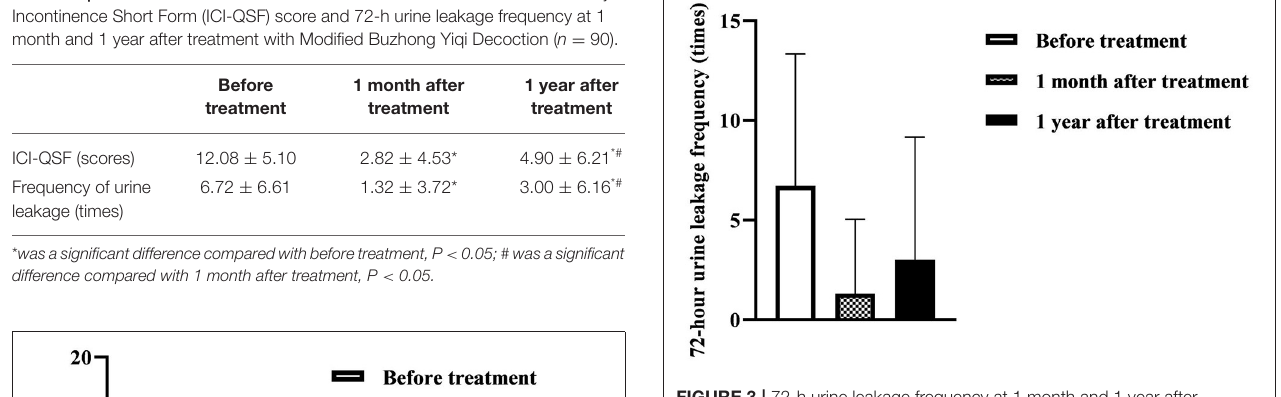
Kidney Qi is weak. Simple application of Buzhong Yiqi